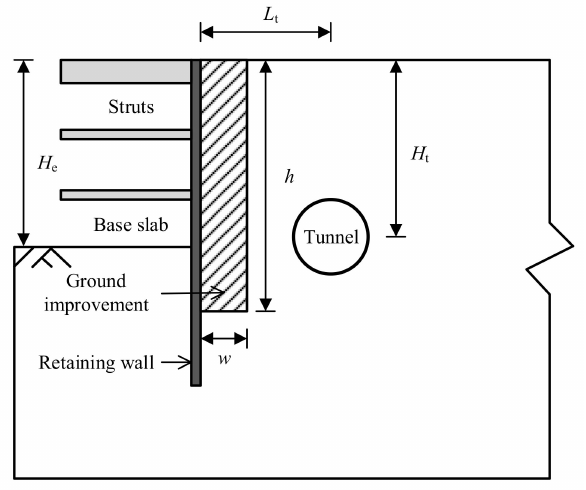
Figure 9. Schematic diagram of ground improvement outside the